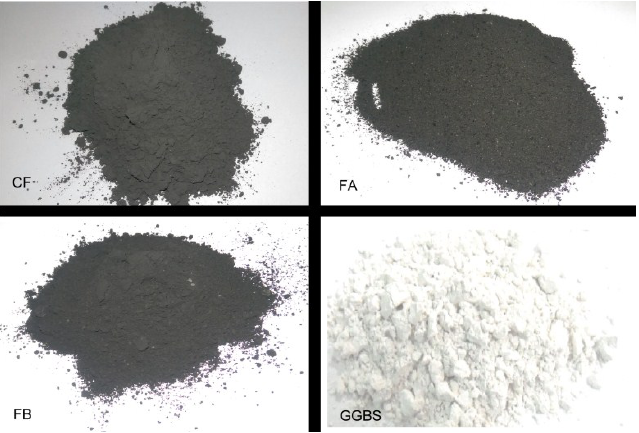
Figure 2. Images of three co-firing fly ashes and ground granulated blast-furnace slag